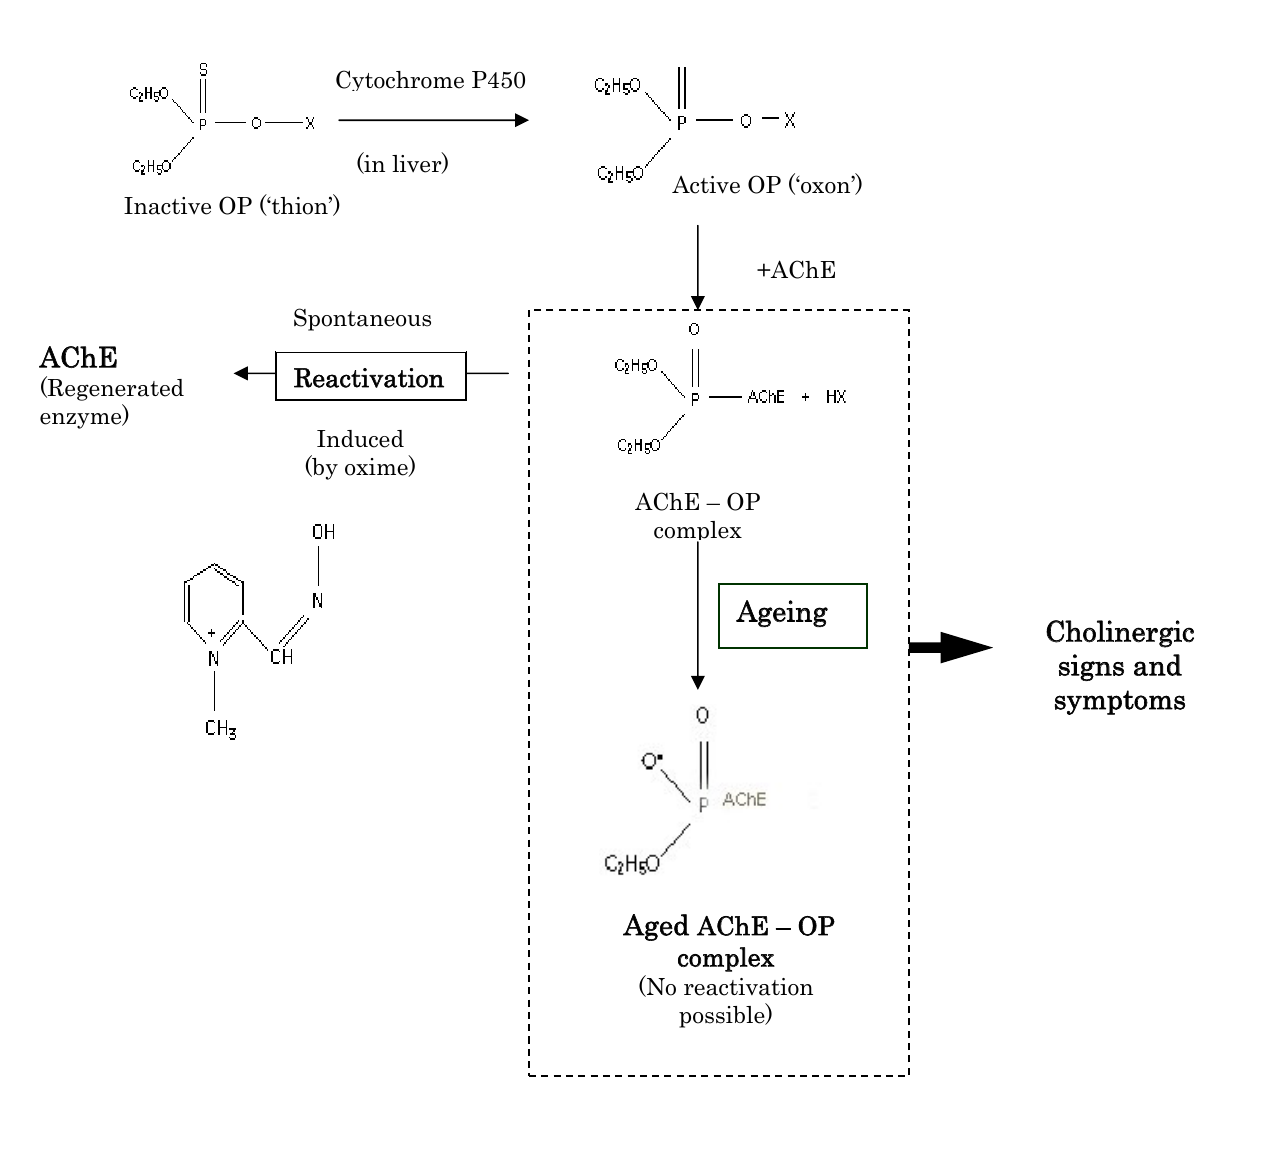
Figure 1. Diagrammatic representation of the possible reactivation & ageing reactions of AChE after inhibition by OP compounds